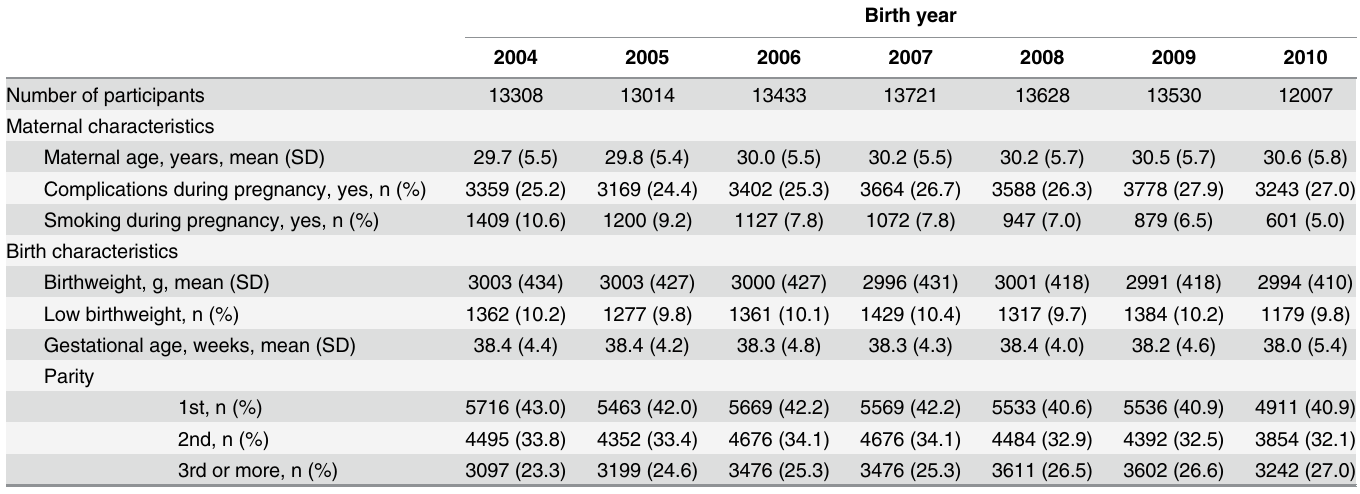
Table 1. Characteristics of participants by birth